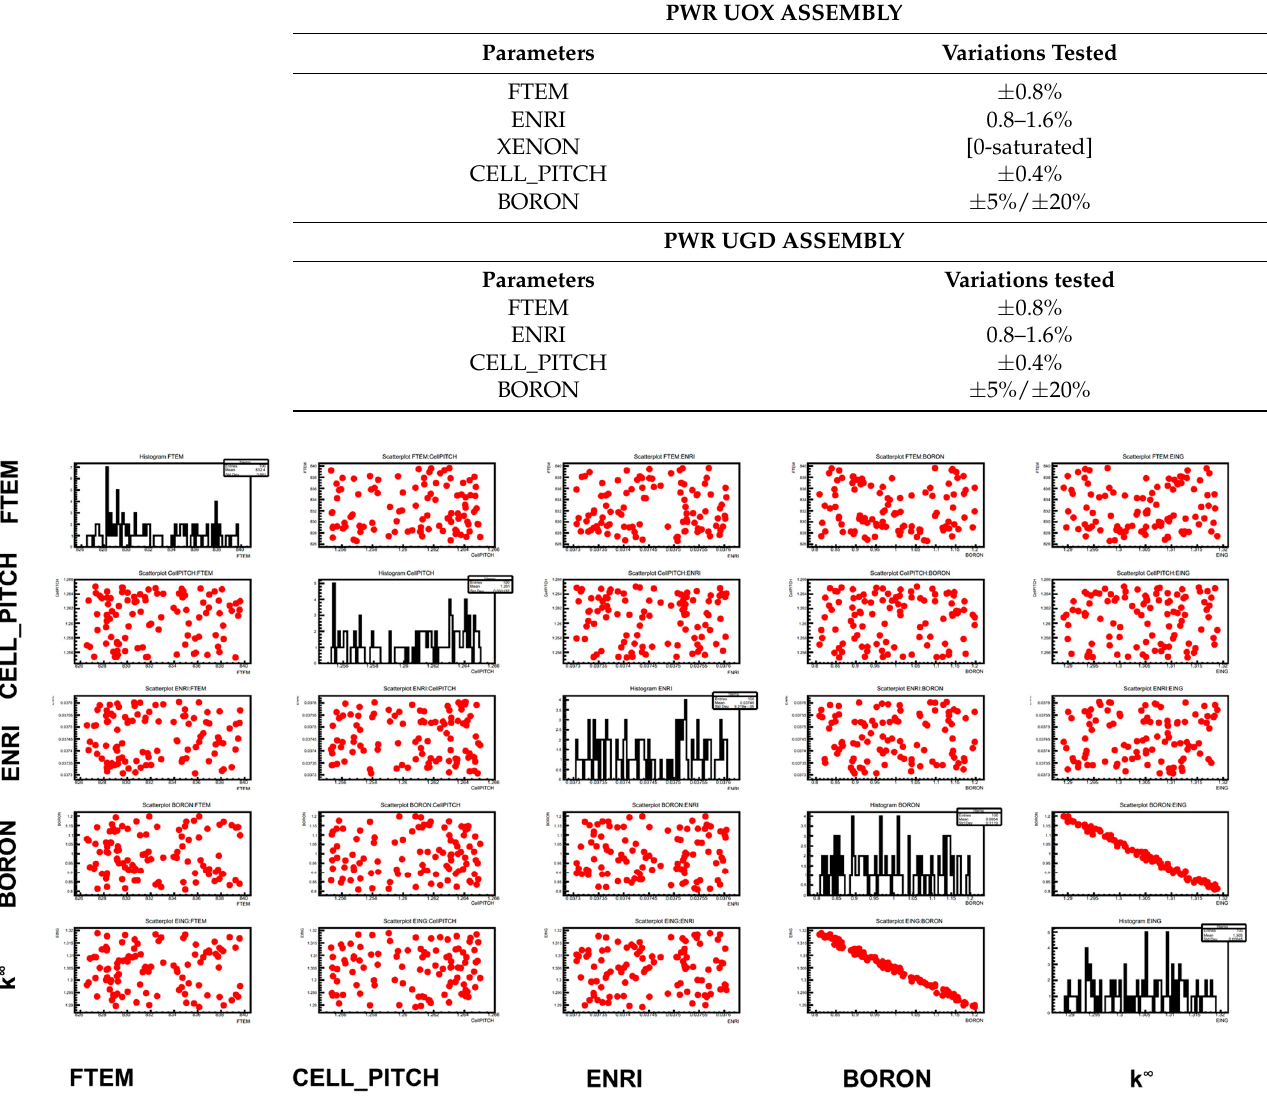
Table 7. ASSEMBLY CASES: parameters and distributions used for the SA.